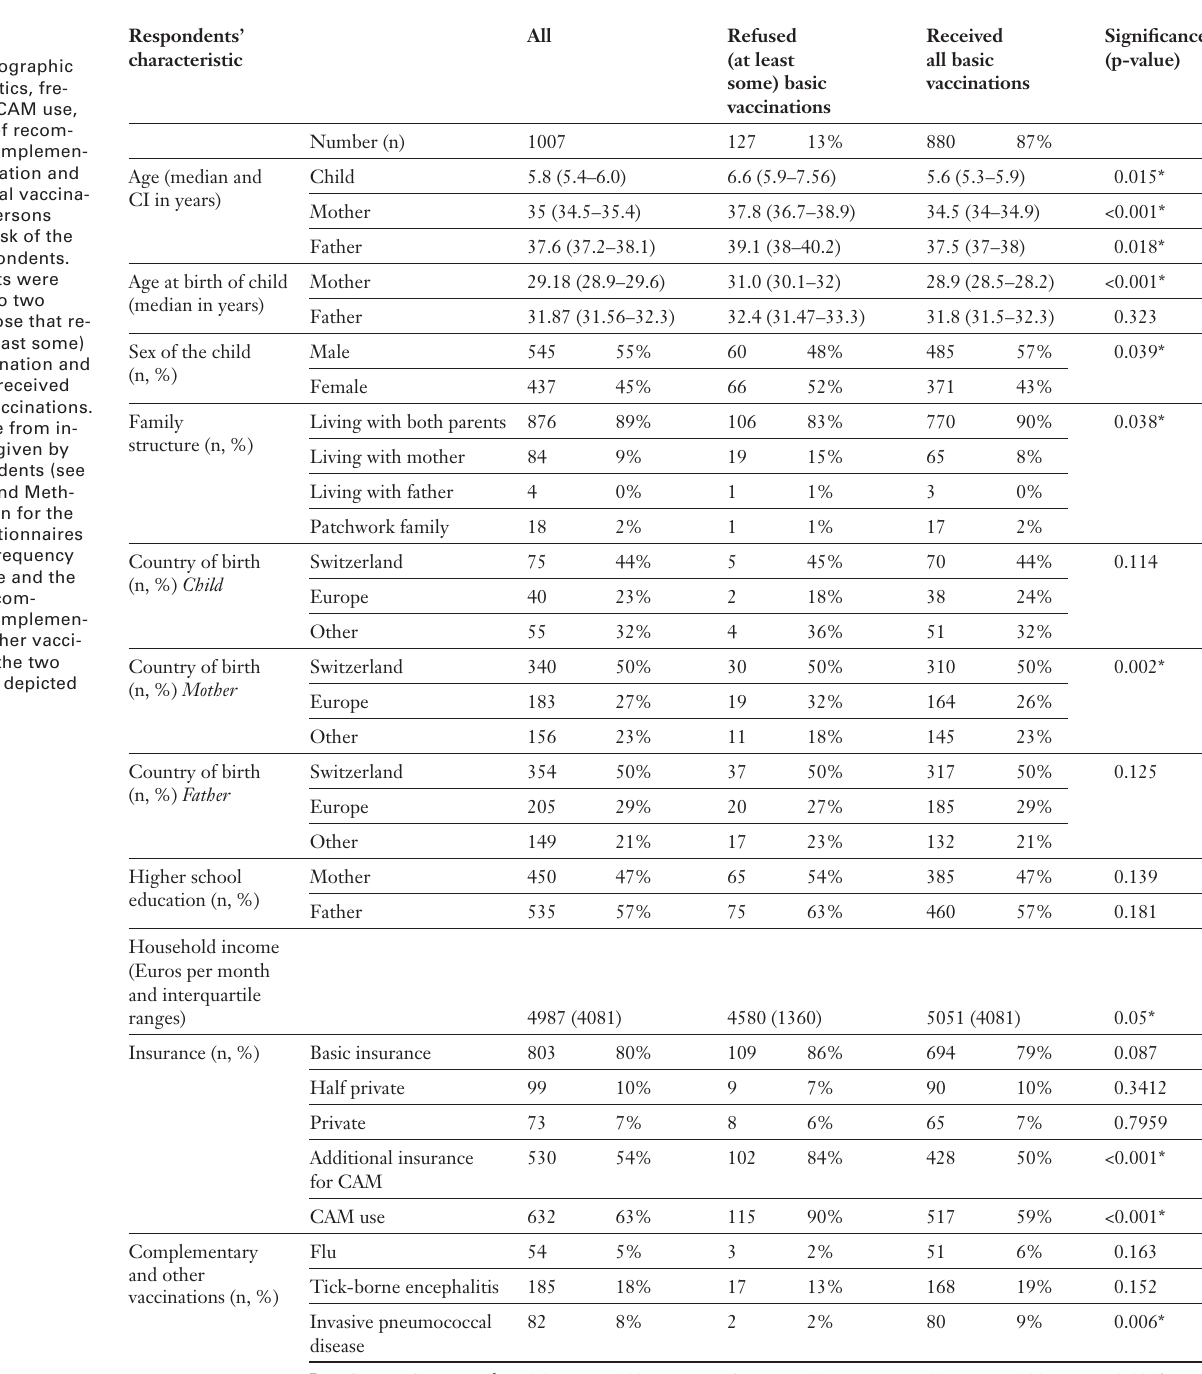
Socio-demographic characteristics, fre- quency of CAM use, and rates of